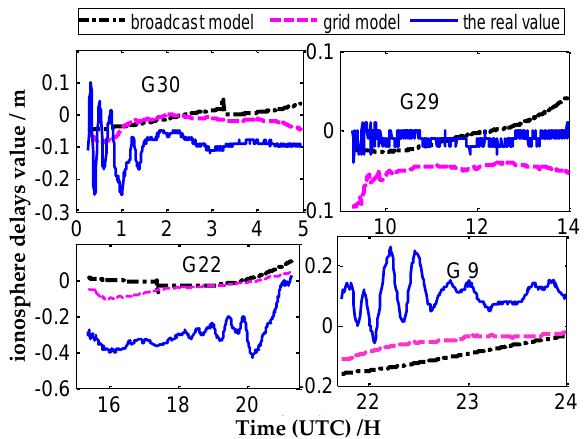
Figure 5. The ionosphere delay values under three ionosphere methods of NANO and ALBH.